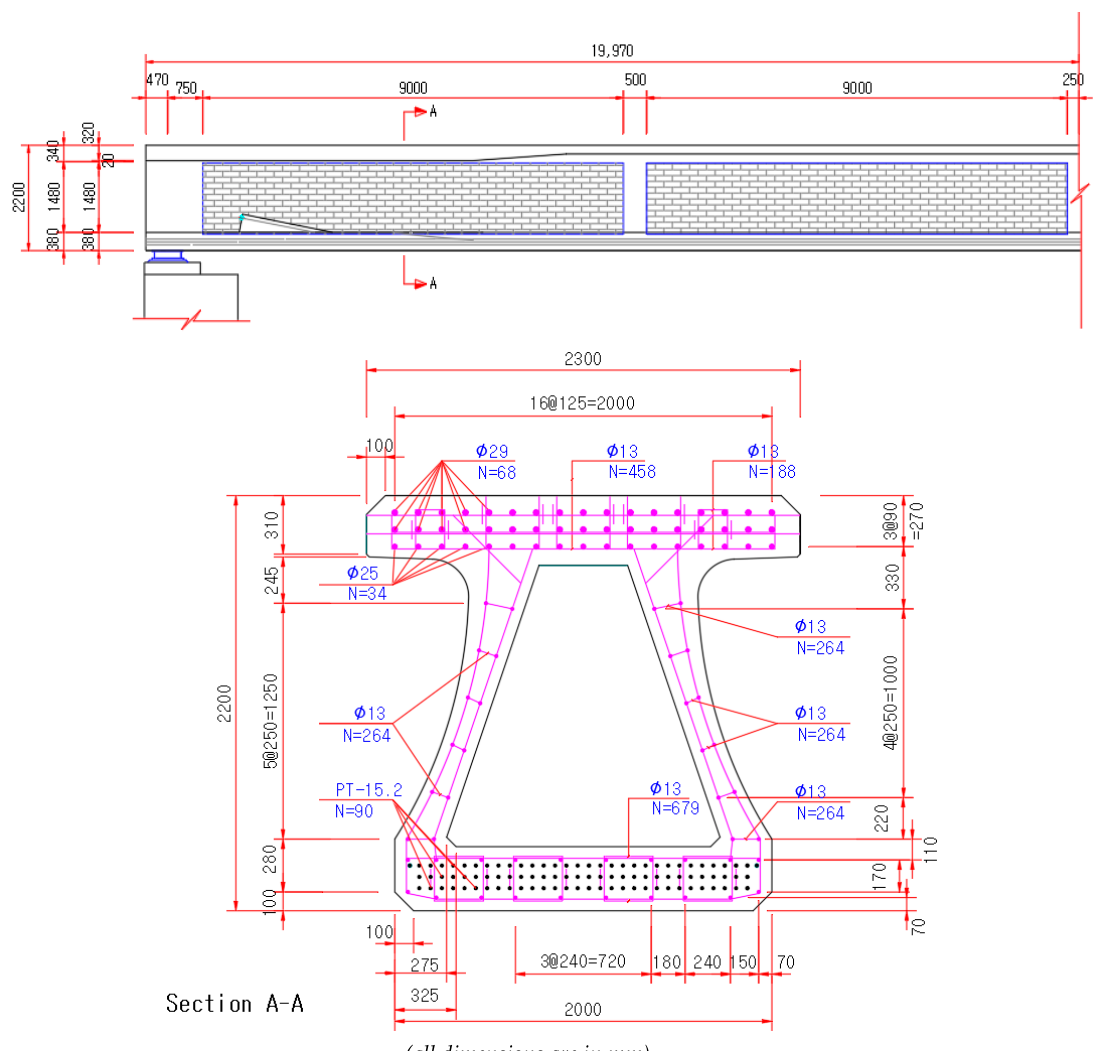
Figure 10. Longitudinal and cross-sectional view of medium-span PSC box girder.